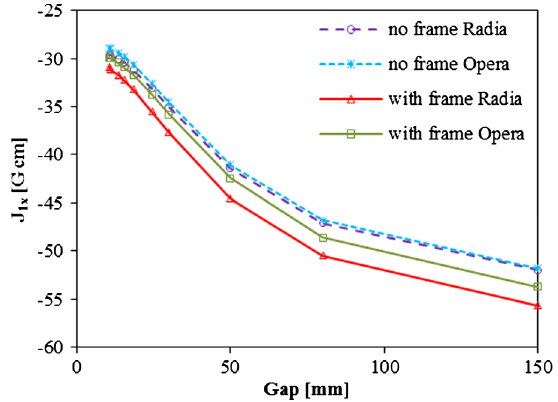
FIG. 7. The horizontal field integrals calculated along the median plane of APS27 #5s. Comparison of the R ADIA and O PERA calculations ( B y ¼ − 0 . 4 , B x ¼ − 0 . 15 gauss) and frame effect.